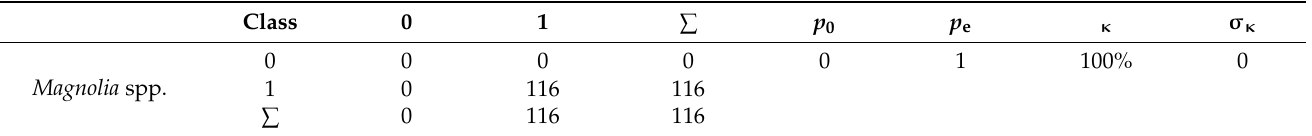
Figure 9. Distribution of M. sulawesiana found in GANP and the production forest at the border of BNWNP in North Sulawesi. Table 8. Accuracy test classification results for Magnolia